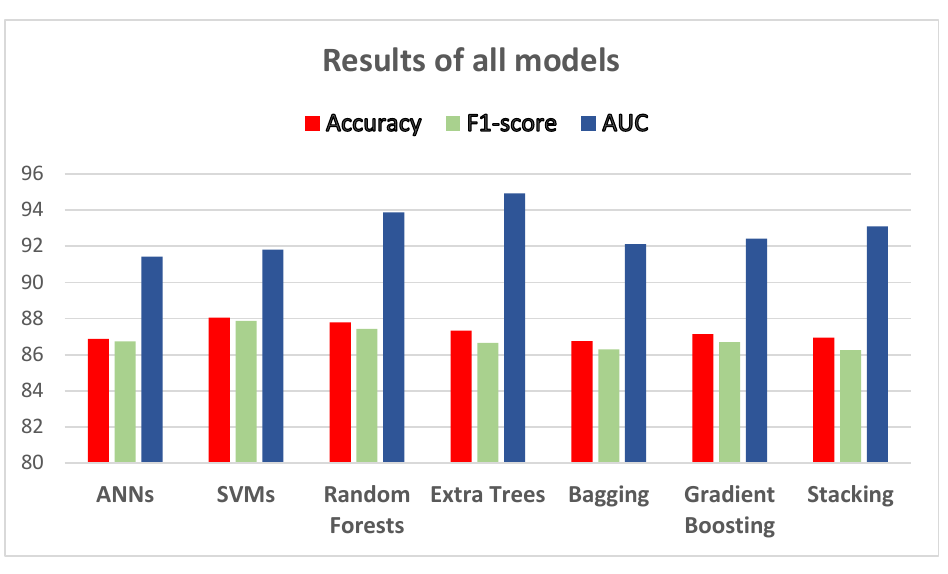
Figure 12. Results of all models. Table 3. Accuracy results for all classifiers.